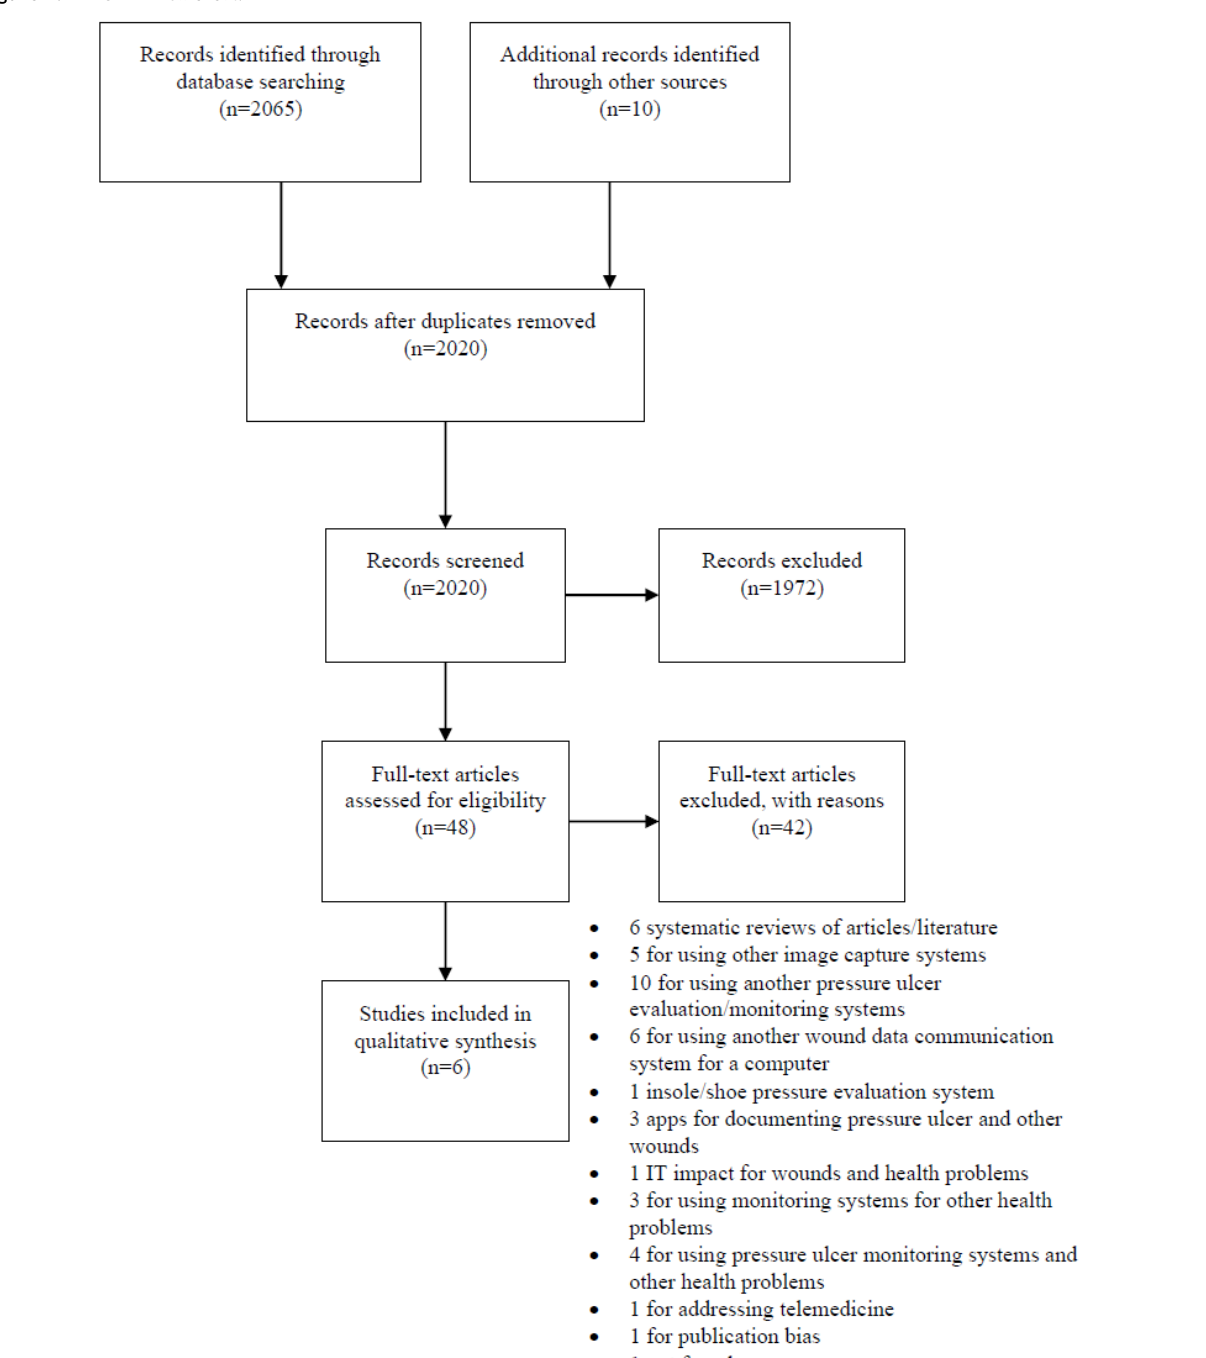
Figure 1. PRISMA